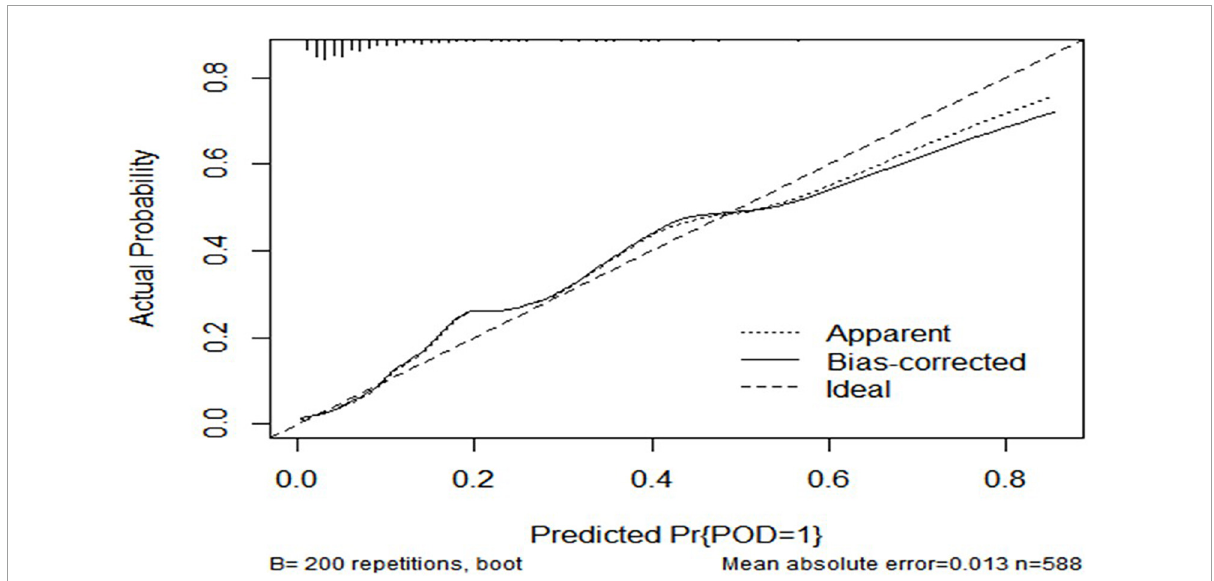
FIGURE6 Predictive model. Calibration curve demonstrating the effectiveness of the predictive model. FBG, fasting blood glucose; A β 42, β -amyloid42; T-tau, total tau; P-tau, phosphorylated tau.